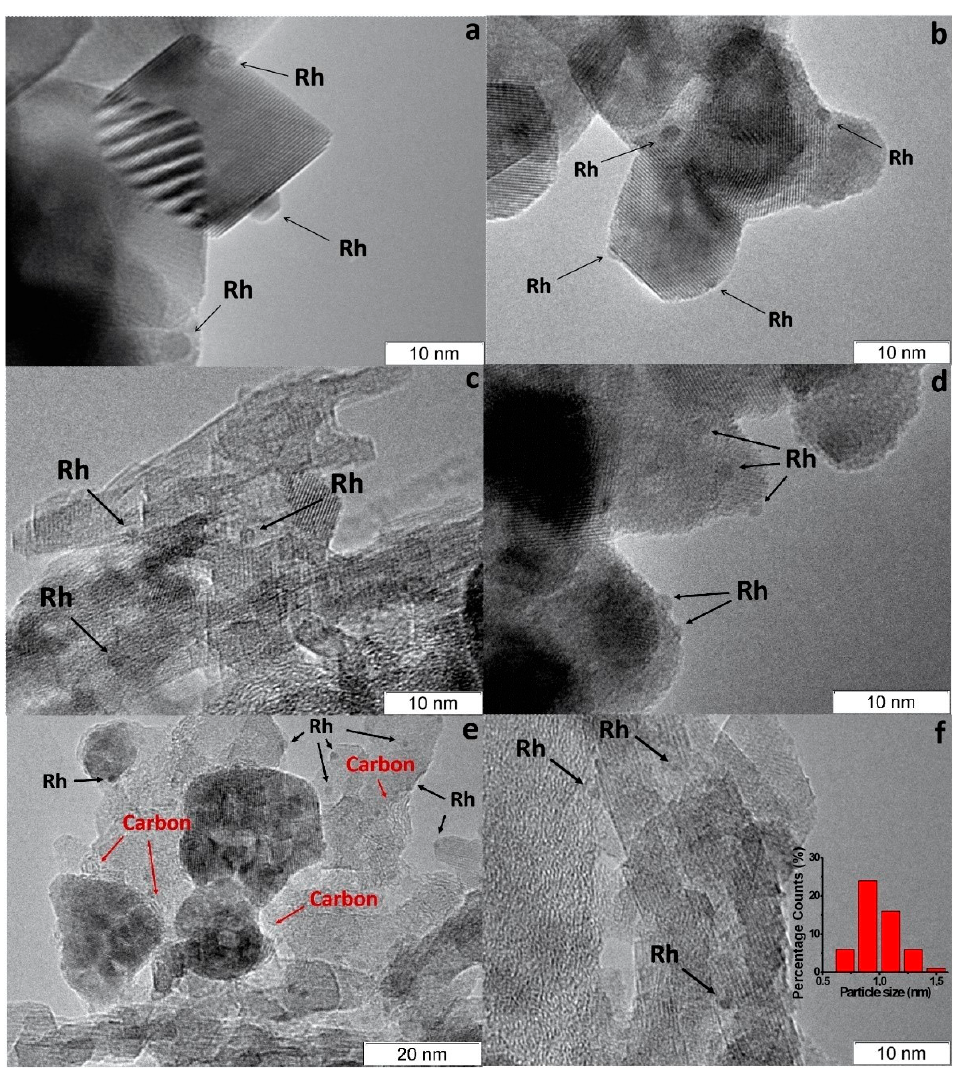
Figure 5. TEM images of as ‐ prepared Rh/CZ ( a ), Rh/CZB ( c ) and used in HD SR Rh/CZ ( b ), Rh/CZB ( d ), Rh/CZA ( e ) and annealed Rh/CZA ( f ) catalysts [50].